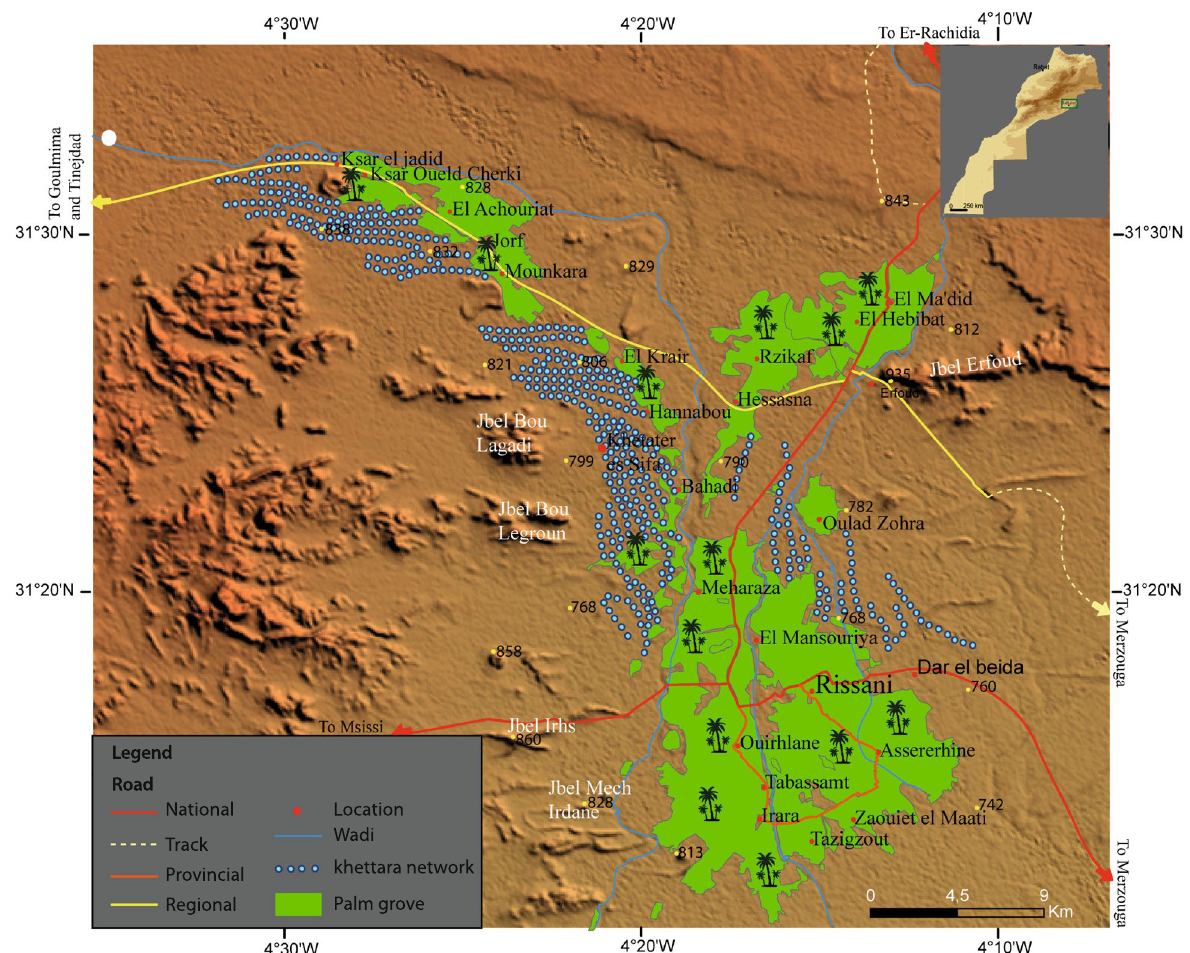
Fig. 7 Distribution map of khettaras in the plain of Tafilalet (Source: the